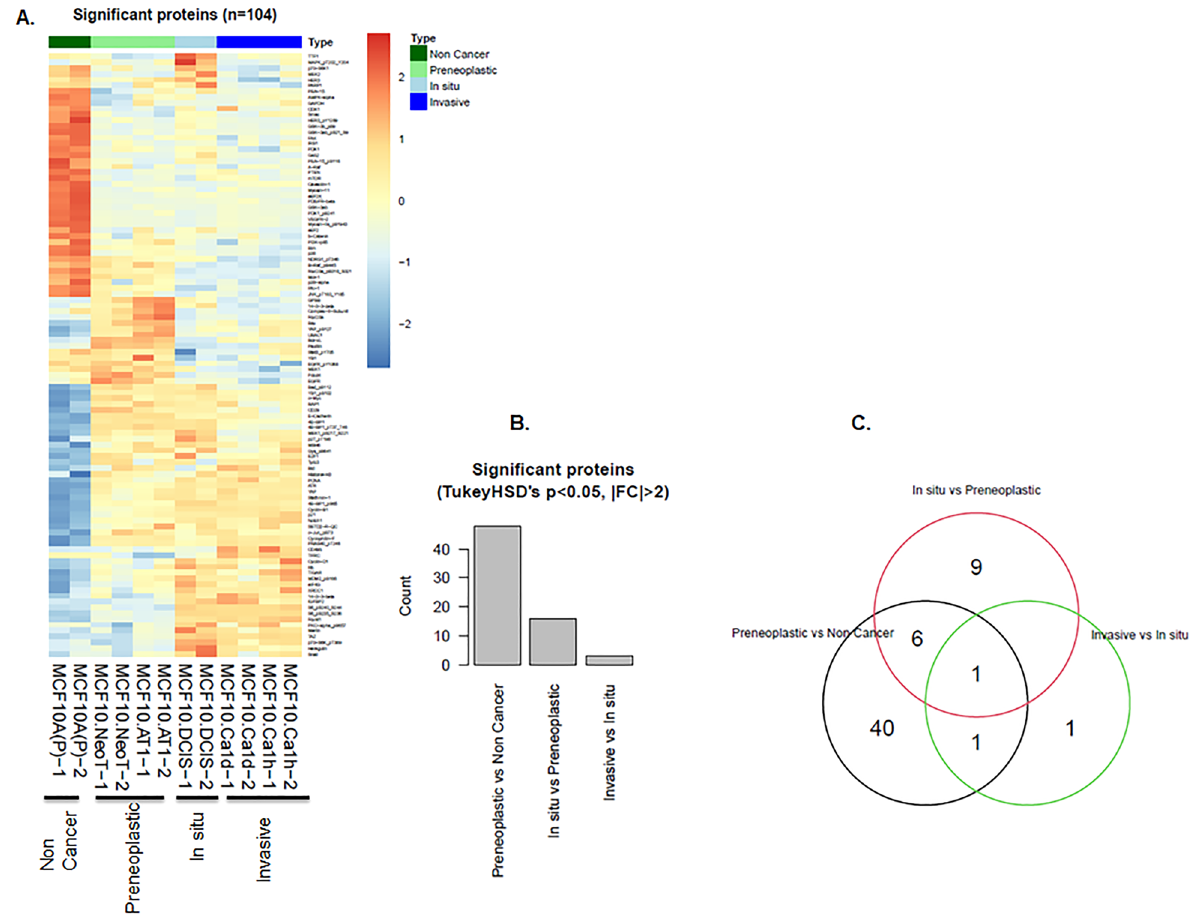
Figure 1. The majority of proteomic landscape changes during breast tumorigenesis in a triple-negative MCF10A cell line-based model occur in the transition from a normal to benign state. ( A – C ) Proteins that significantly changed during various stages of TNBC progression. ( A ) Heatmap generated from RPPA data shows an overview of alterations. Each row represents a specific protein’s highest expression (orange) or lowest expression (blue) in the various cell lines. Two replicates are shown for each cell line. ( B ) Bar diagram shows the number of proteins that changed for each transition from one stage of TNBC progression to another. ( C ) Venn diagram shows the number of deregulated proteins that overlapped between the indicated stage